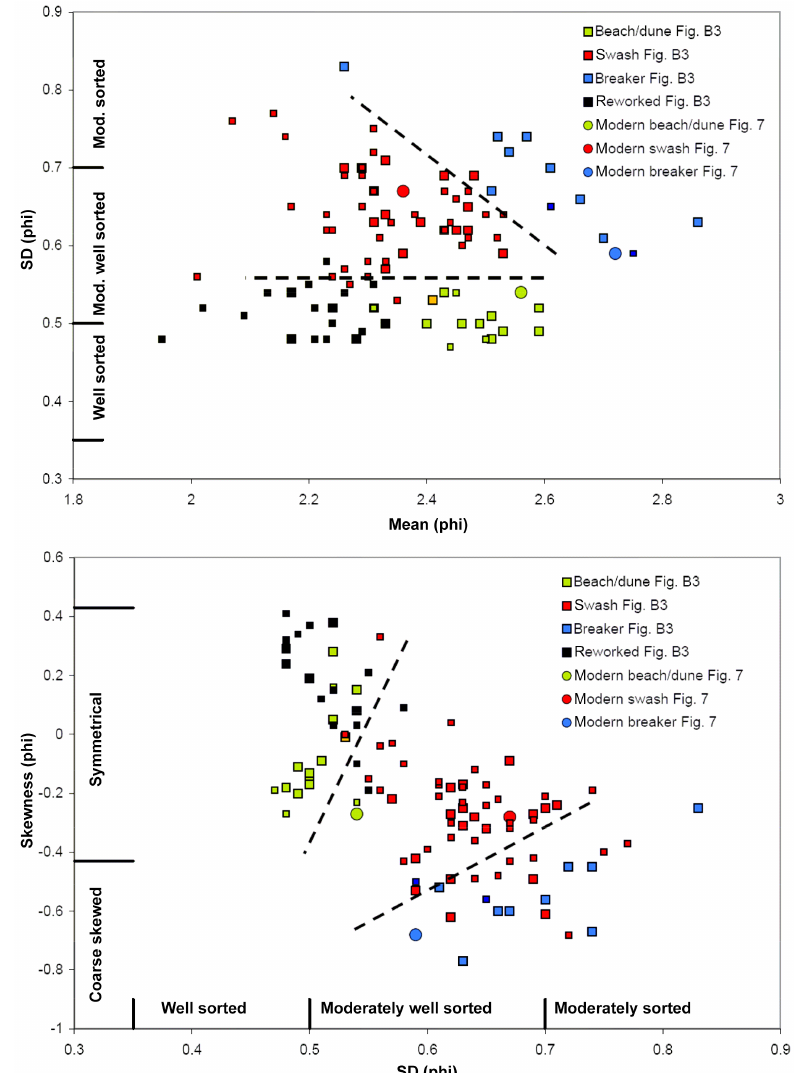
Figure B4. Grain-size statistical parameters calculated with the logarithmic method of moments (Blott and Pye, 2001). Sample locations are indicated in Fig.